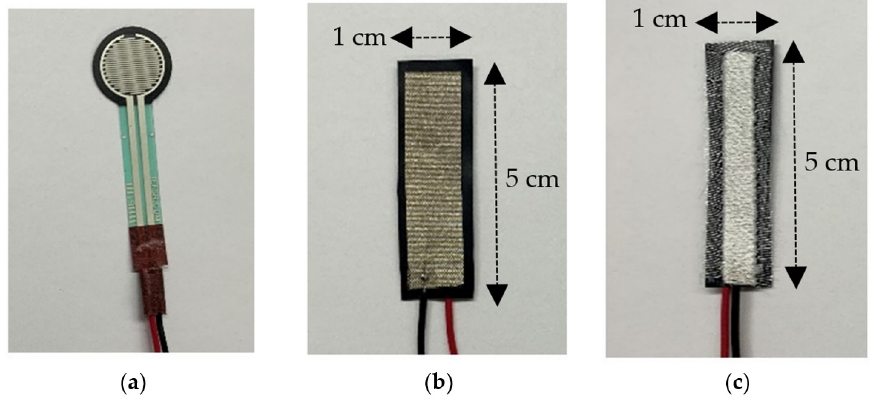
Figure 3. FSR designs explored in this work: ( a ) off-the-shelf FSR; ( b ) thru-mode FSR with woven conductive fabric; ( c ) thru-mode FSR with embroidered e-threads.